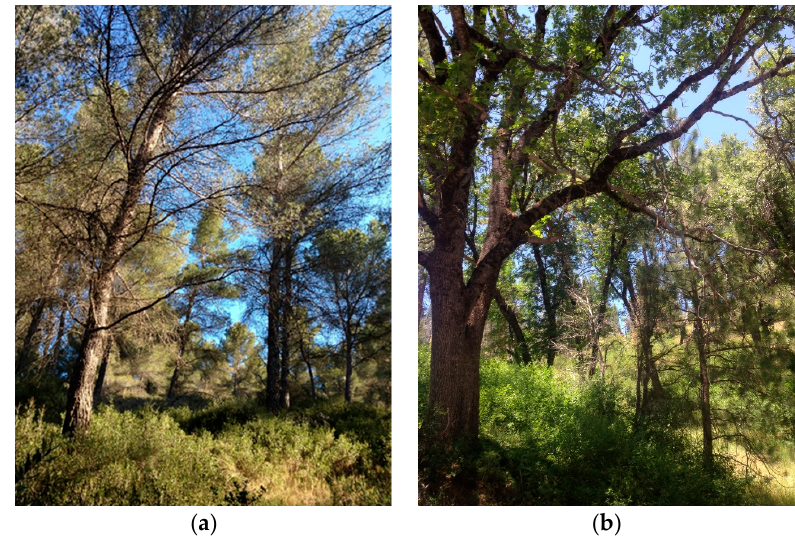
Figure 1. ( a ) Typical fire-adapted forest in Mediterranean France with Aleppo pine ( Pinus halepensis ), green oak ( Quercus ilex ), and pubescent oak ( Quercus pubescens ), March 2016. ( b ) Typical fire-adapted forest in the Sierra Nevada in Amador County with ponderosa pines ( Pinus ponderosa ) and black oaks ( Quercus kelloggii ), June 2015.